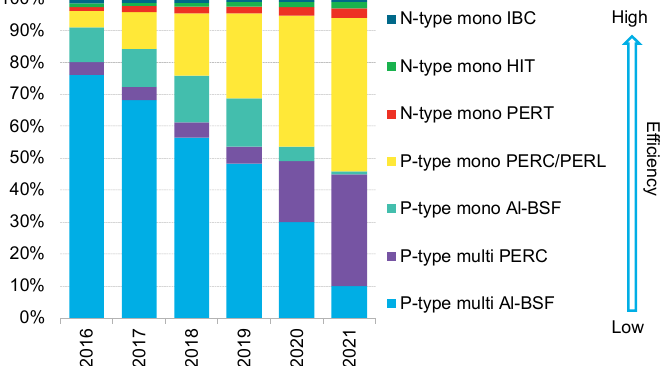
Figure 15. Market share of different c-Si PV modules. Note: IBC is short for interdigitated back contact. HIT: heterojunction with intrinsic thin layer. PERC: passivated emitter and rear cell. PERL: passivated emitter, rear locally-diffused. PERT: passivated emitter, rear totally-diffused. Al-BSF: aluminum back surface field. Source: BloombergNEF.